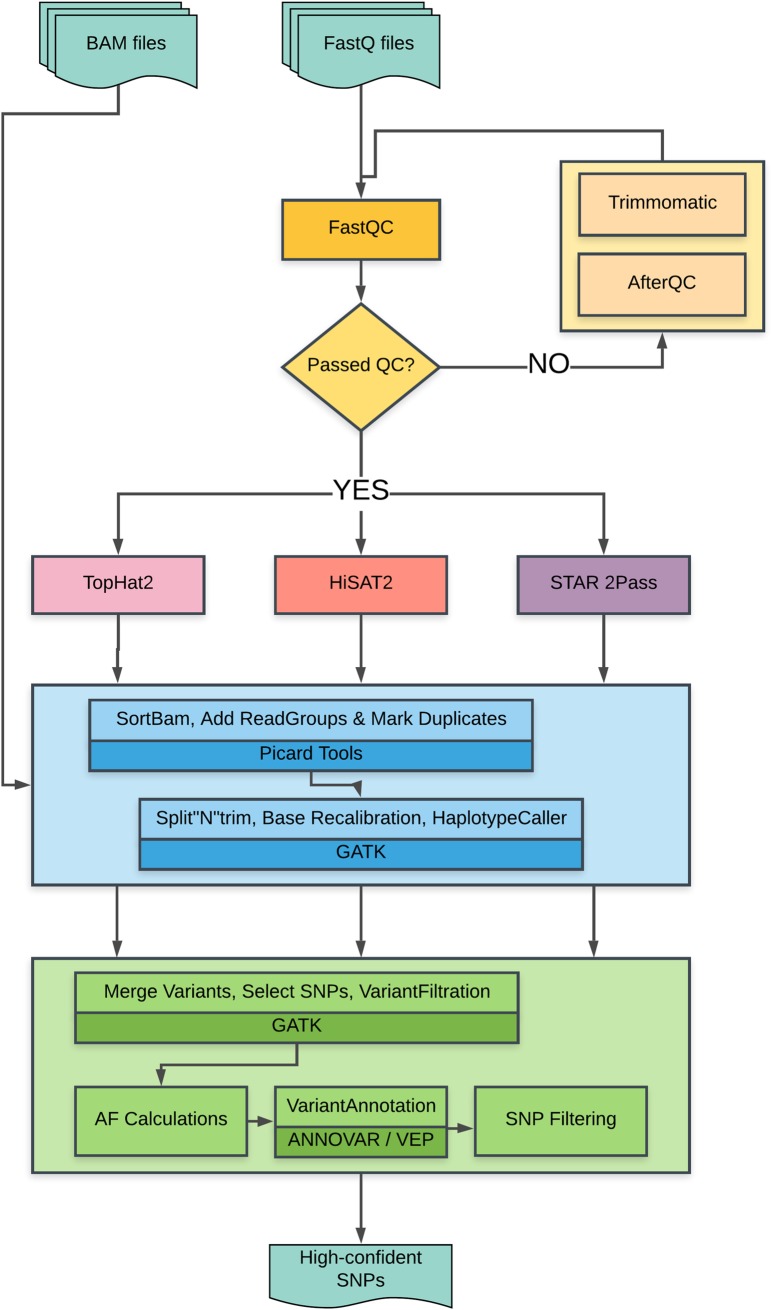
Flow chart of the VAP workflow.FastQ files are QC using FastQC, mapped using three aligners. BAM files are pre-processed by Picard and GATK, then merged, annotated and filtered to achieve high-confident SNPs.